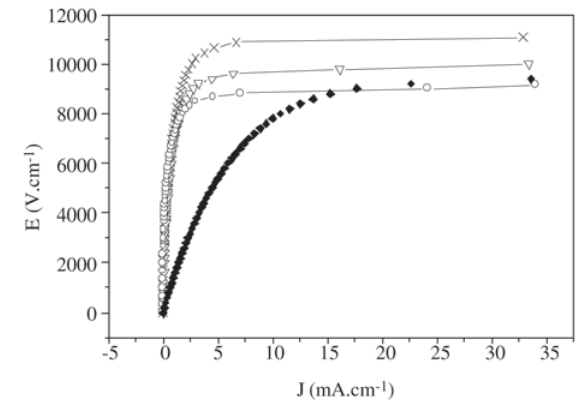
Figure 5. I-V characteristic curves of compositions sintered for